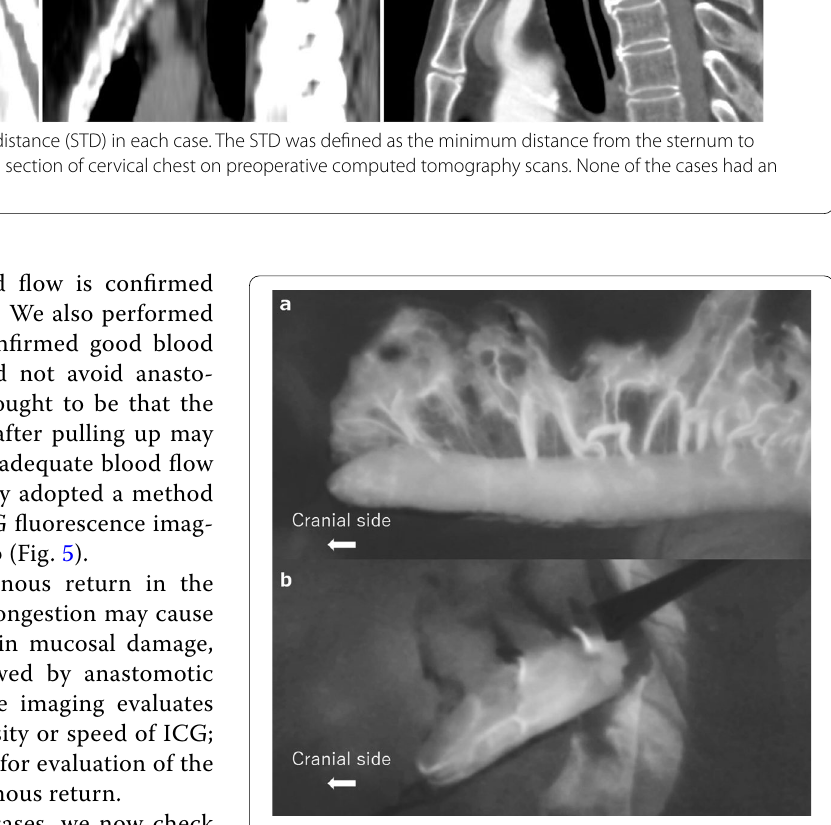
Fig. 5 Indocyanine green fluorescence imaging in another recent case. We adopted a method of confirming the blood flow in the conduit both before ( a ) and after ( b ) pulling